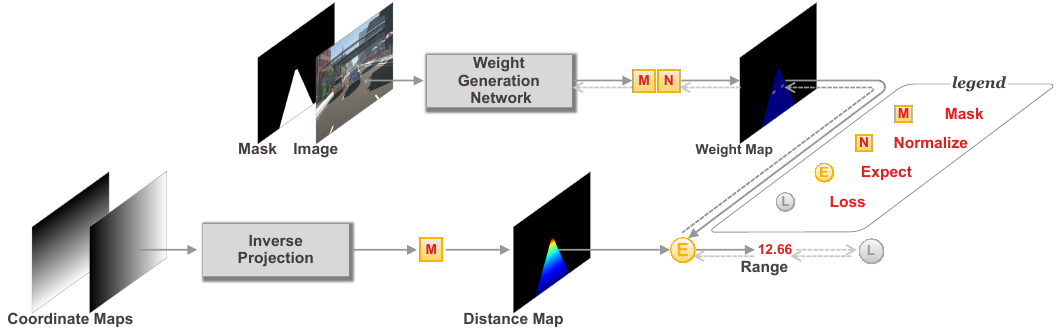
Figure 1. Overview of architecture. The range is represented as a weighted sum of a set of potential distances and the whole architecture consists of weight map generation and distance map generation. The solid lines with arrows represent the forward implementation of our method, while the dashed lines with arrows indicate the loss calculation and back-propagation in the training